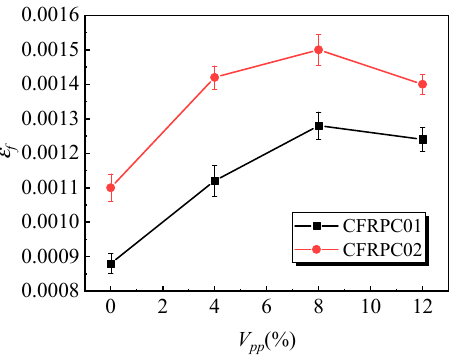
Figure 7. E ff ect of the polymer–cement ratio on the peak strain in the flexural Figure 7. Effect of the polymer–cement ratio on the peak strain in the flexural test .